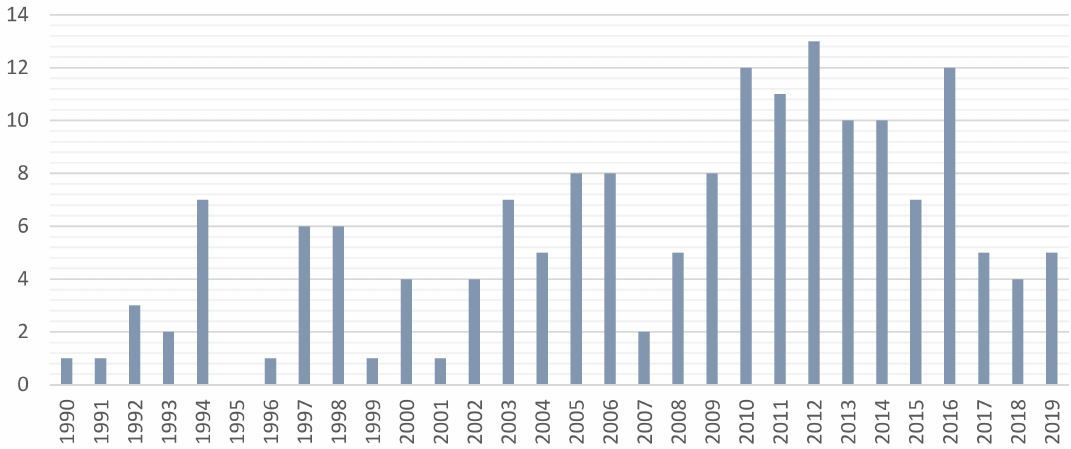
Figure 1. Temporal distribution of the number of documents